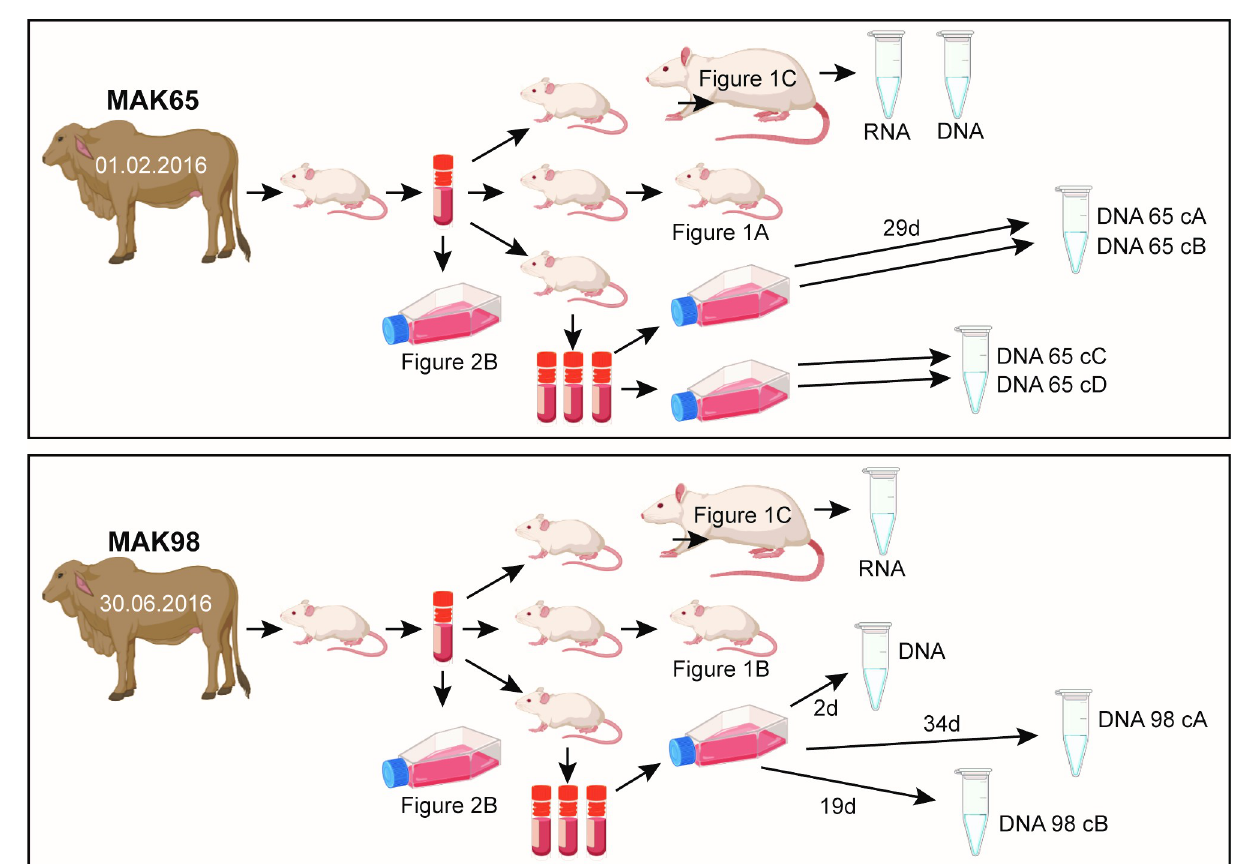
Fig 1. Parasite histories and culture. The small pictures are from Biorender.com. (https://app.biorender.com).